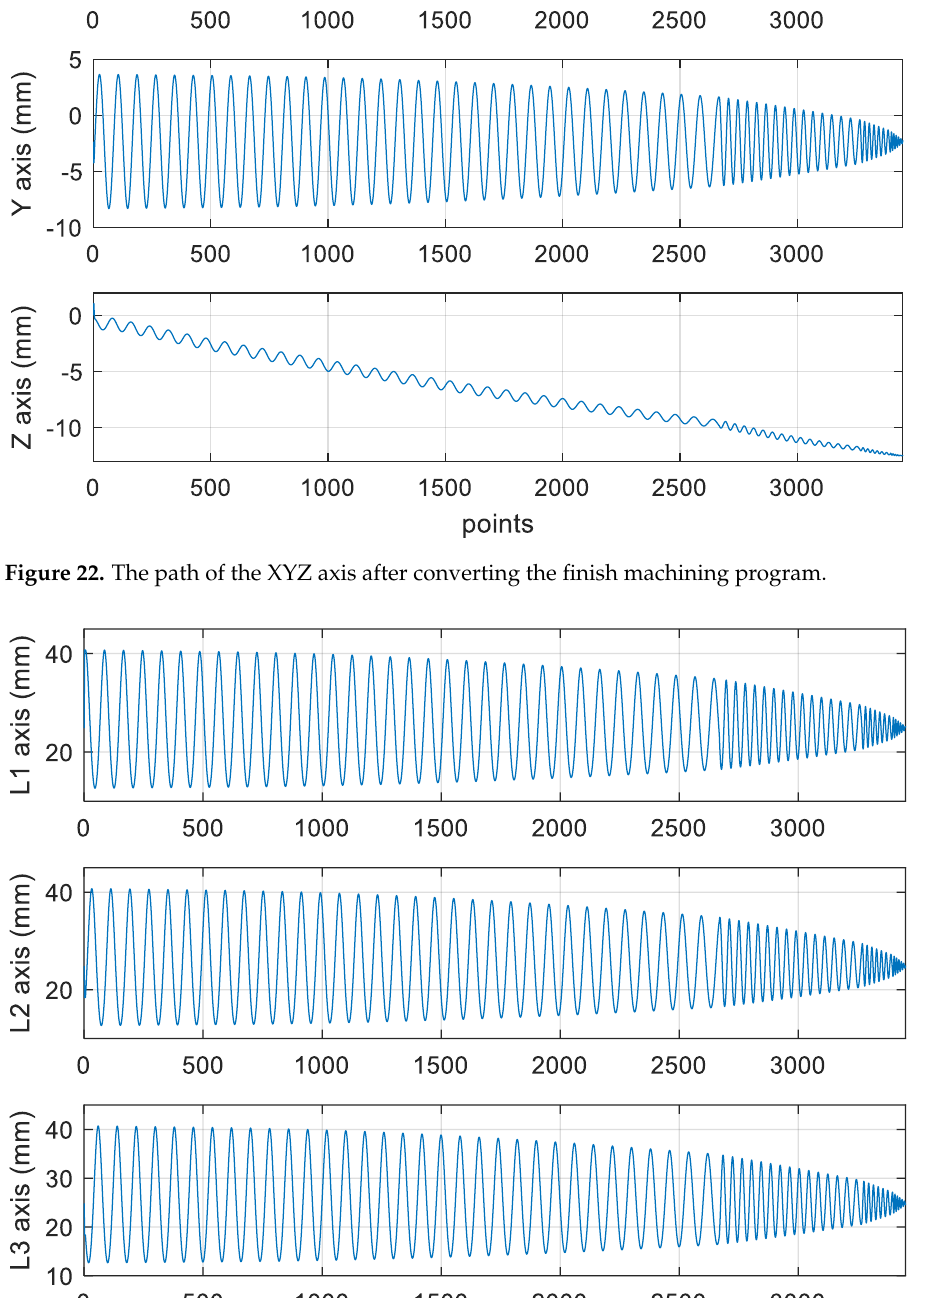
Figure 24. Three-dimensional image of the XYZ path after converting the finish machining pro- gram.